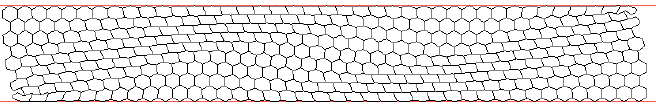
Figure 13. Deformed shape of Type II honeycomb with the 40:9